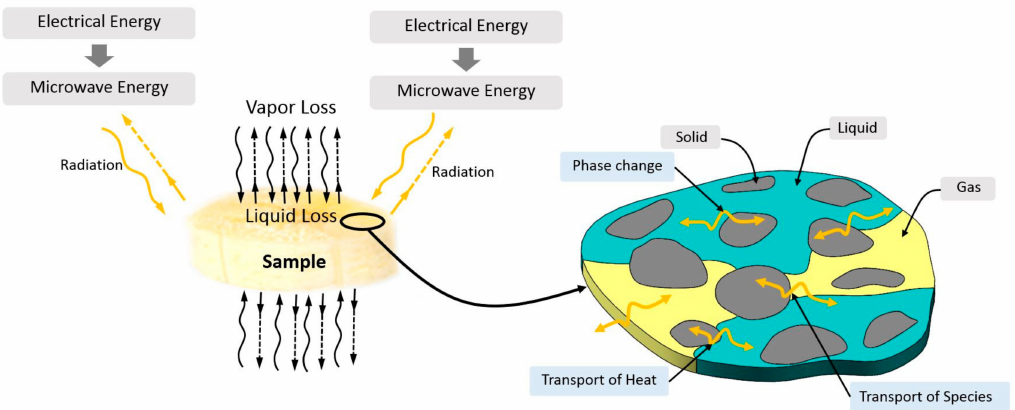
Figure 1. Heat and mass transfer of a sample with representative elementary volume (REV) showing transport, reaction, and phase change in porous media.